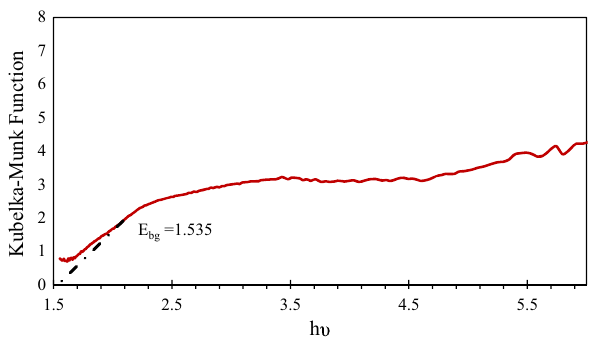
Fig. 6 Kubelka–Munk plot of Fe +3 –TiO